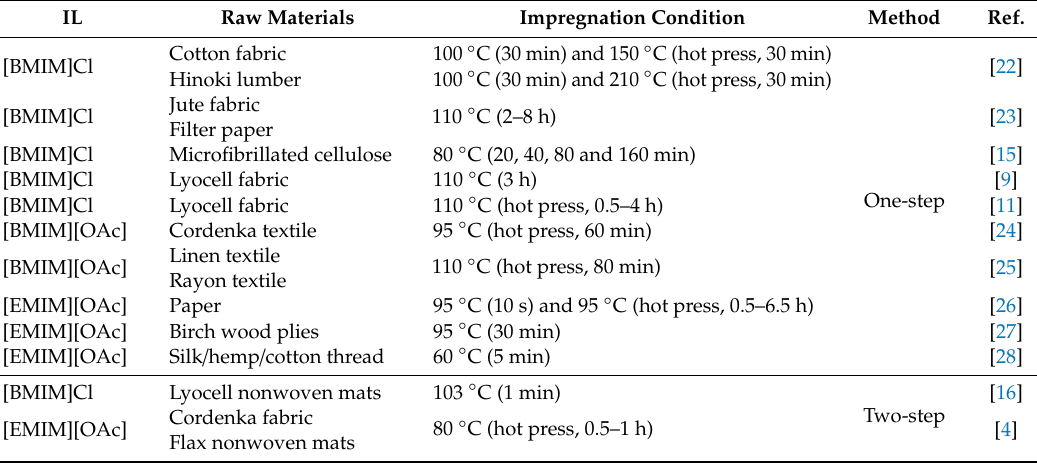
Table 1. Summary of all-cellulose composites (ACCs) manufactured using the imidazolium-based